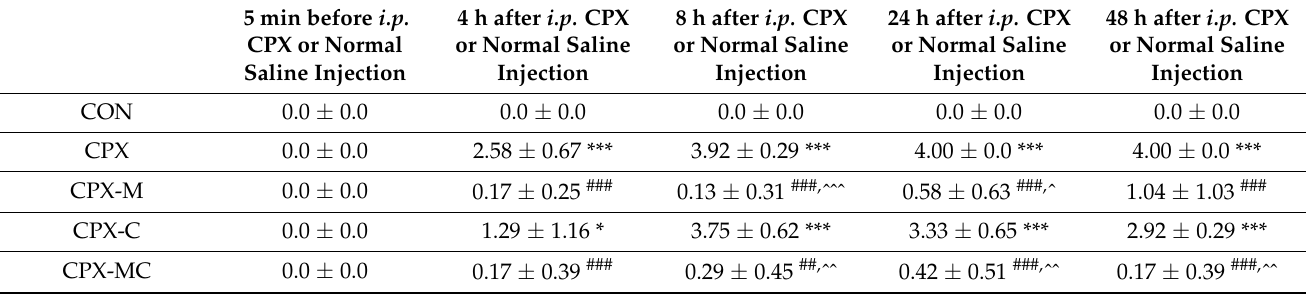
Table 1. Statistical comparisons of hematuria measured semi-quantitatively on the dipstick test between studied groups. Mean values of hematuria in the studied time points with corresponding SD are presented in Figure 4. A detailed description of experimental groups is presented in Figure 1 and in the Materials and Methods section. * p < 0.05, *** p < 0.001 vs. CON group; ## p < 0.01, ### p < 0.001 vs. CPX group; ˆ p < 0.05, ˆˆ p < 0.01, ˆˆˆ p < 0.001 vs. CPX-C group.